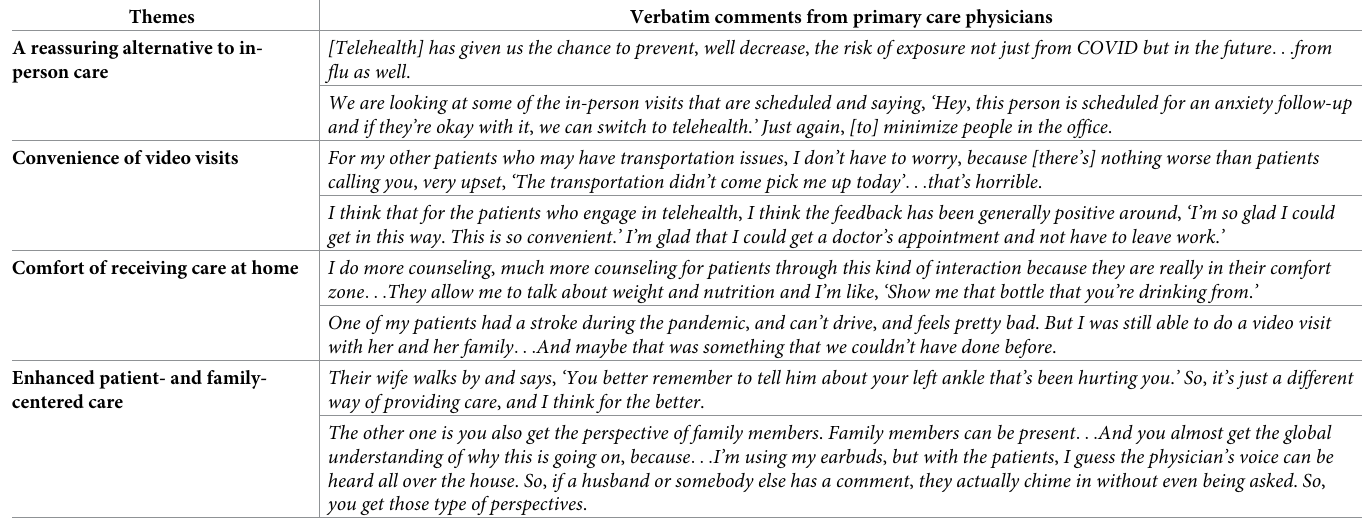
Table 1. Physicians’ perspectives about advantages of providing remote care for